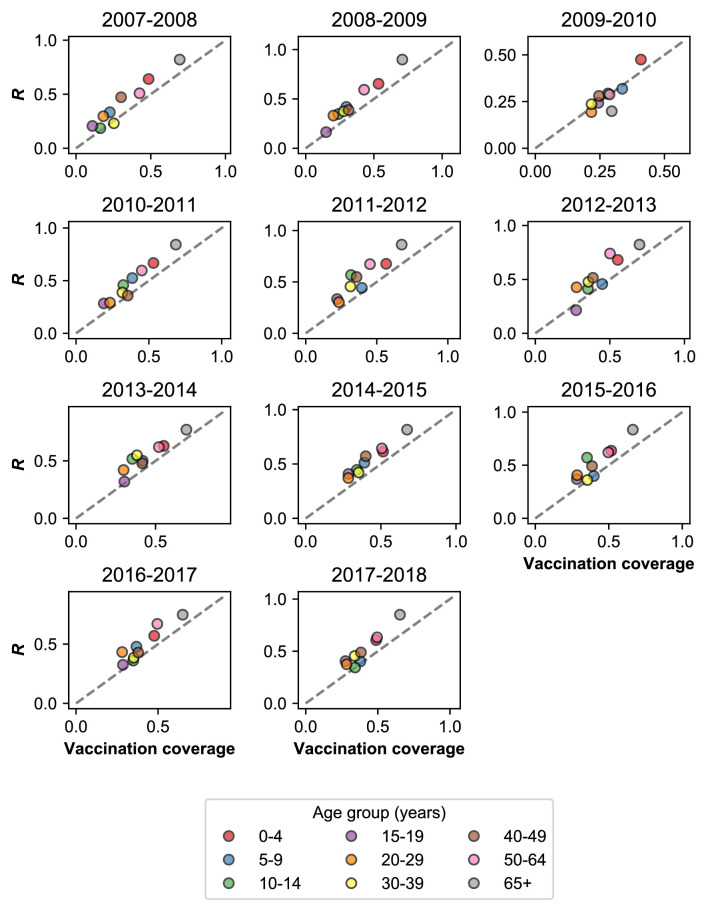
Rate of MAARI in vaccinated and unvaccinated controls.Vaccinated individuals seek healthcare for MAARI at a higher rate than predicted by vaccination coverage. We measured the fraction of vaccinated people among all who presented with MAARI and tested negative for influenza (R=Vaccinated test-negative controlsUnvaccinated test-negative controls+Vaccinated test-negative controls; Materials and methods: ‘Vaccination’). This is plotted against vaccination coverage by season for different age groups. The dashed grey line shows where R and vaccination coverage are equal. Vaccination coverage for the 2009–2010 season uses monovalent vaccination coverage estimated directly from all individuals with MAARI. We do not show the 2009 pandemic season because the monovalent vaccine was not distributed until the second wave of the pandemic.